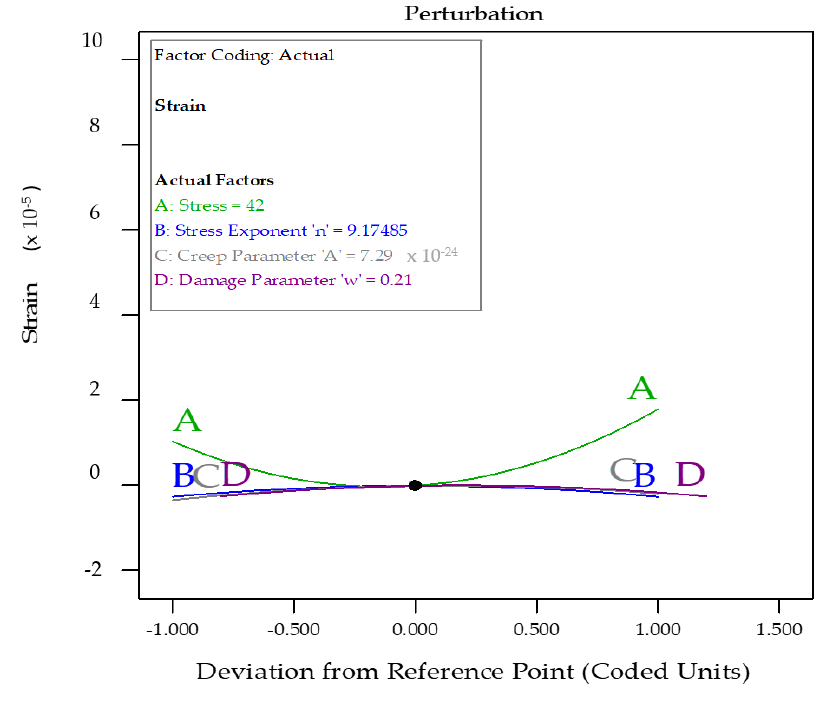
Figure 18. Pertubation plot depicting the effects of all variables simultaneously with a central ref-